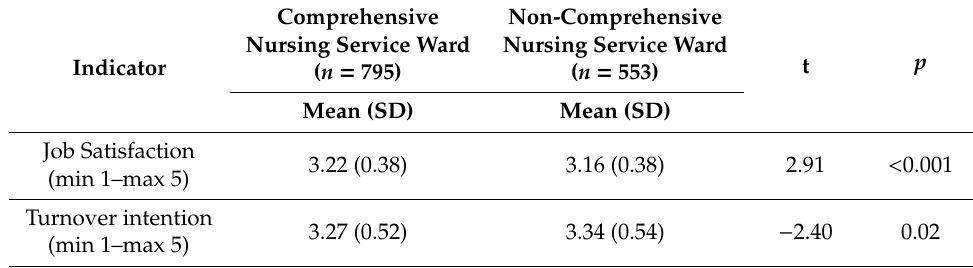
Table 3. Job Satisfaction and Turnover Intention among Nurses ( n =